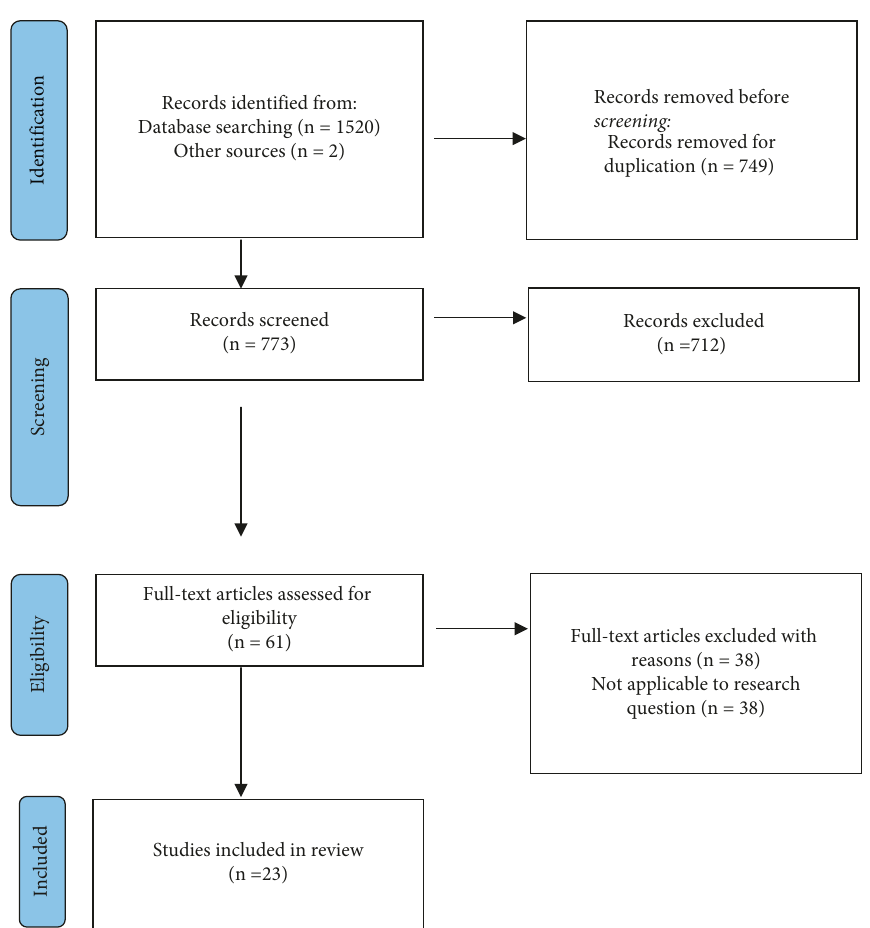
Figure 1: PRISMA flow diagram of the study selection